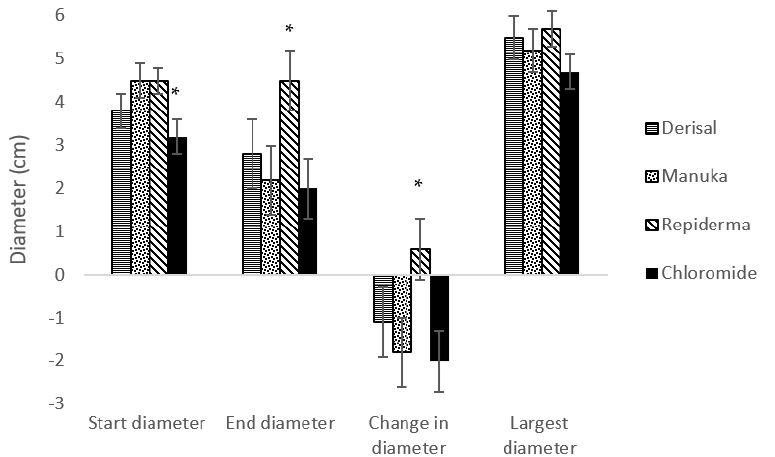
Figure 2. Mean ± SEM of sore diameter characteristics for sows treated daily with topical treatments of Derisal ® , m ānuka, Repiderma ® or Chloromide ® . Asterix (*) signifies a significance of p ≤ 0.05. Start and end diameter refers to the diameter of the shoulder sore at the start and end of the treatment period, with the change being the end minus the start diameter.